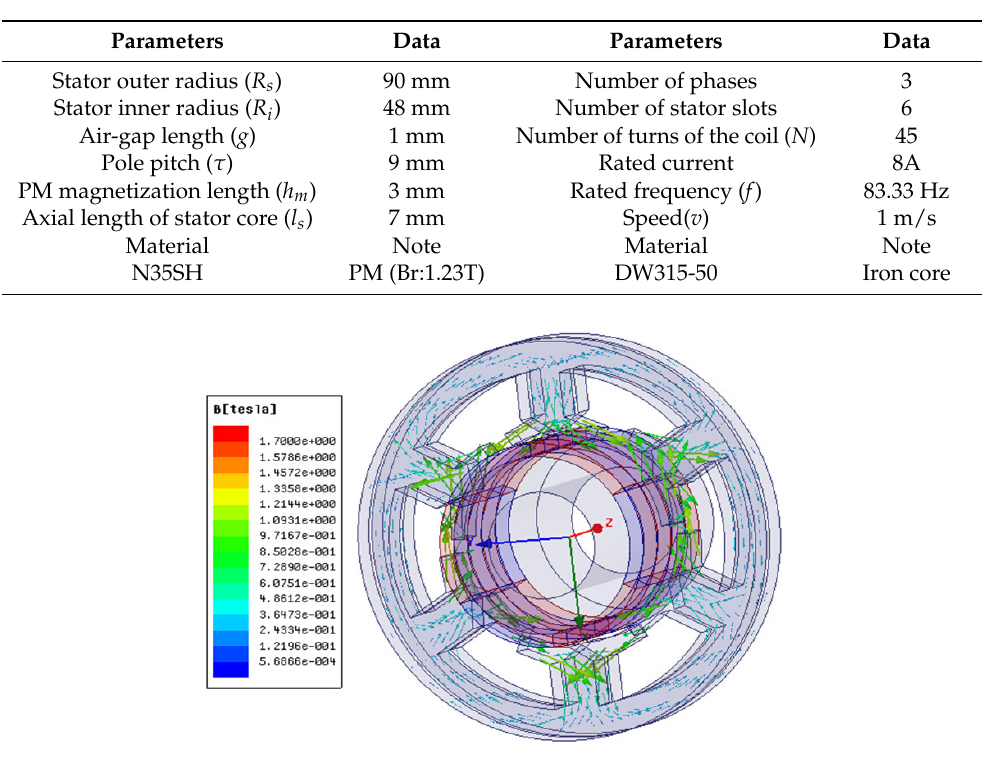
Table 1. Main Design Specifications of STTF ‐ PMLSM.